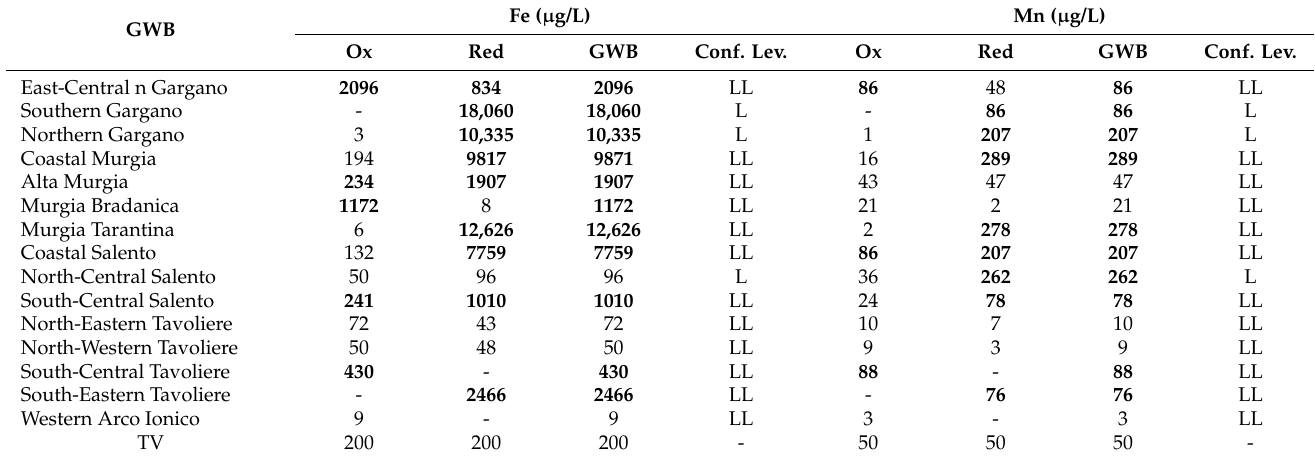
Table 7. Defined NBLs and associated confidence levels for iron and manganese. NBLs above the threshold values are shown in bold. L = low; LL = very